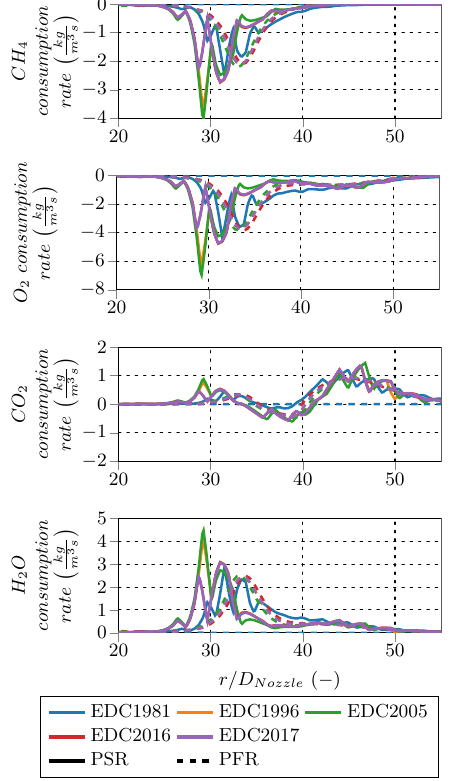
Figure 13. Centerline profiles of main species (CH 4 , O 2 , CO 2 , and H 2 ) production or consumption rates of flame D for all EDC model variations. Not all EDC versions are visible due to overlapping profiles. Energies 2018 , 11 , 1